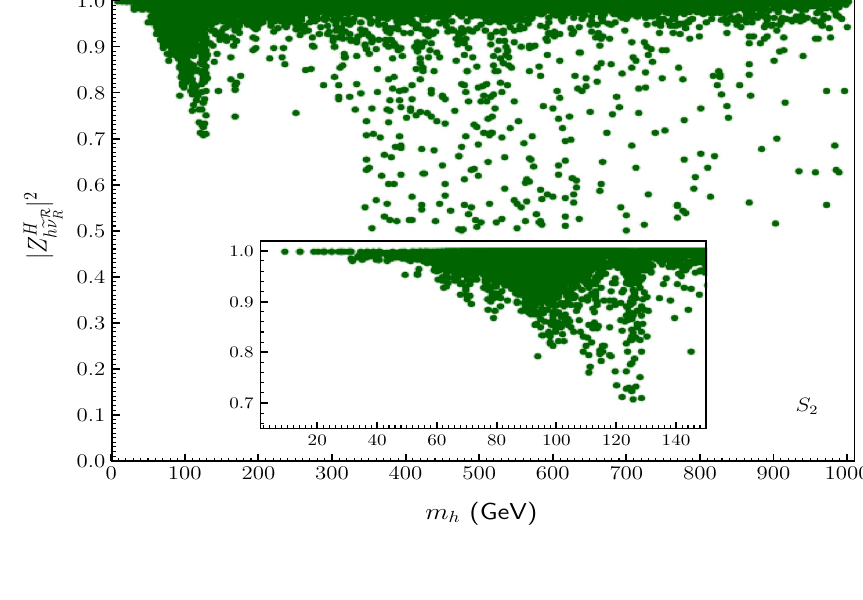
Fig. 10 The singlet component (cid:8) | Z H | 2 of the singlet-like i h (cid:6) ν R iR scalars h versus their masses, for S 2 . We only show here viable points with scalar masses smaller than 1000 GeV. In the lower part we zoom in the low-mass region